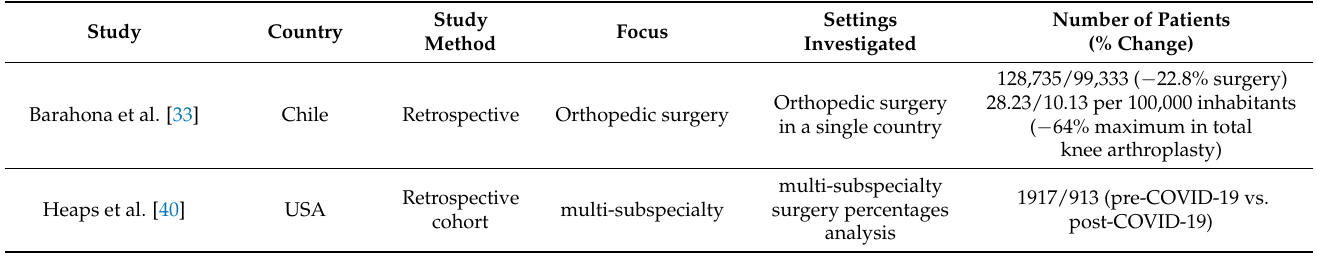
Table 6. Characteristics of relevant publications on orthopedic performance in America.